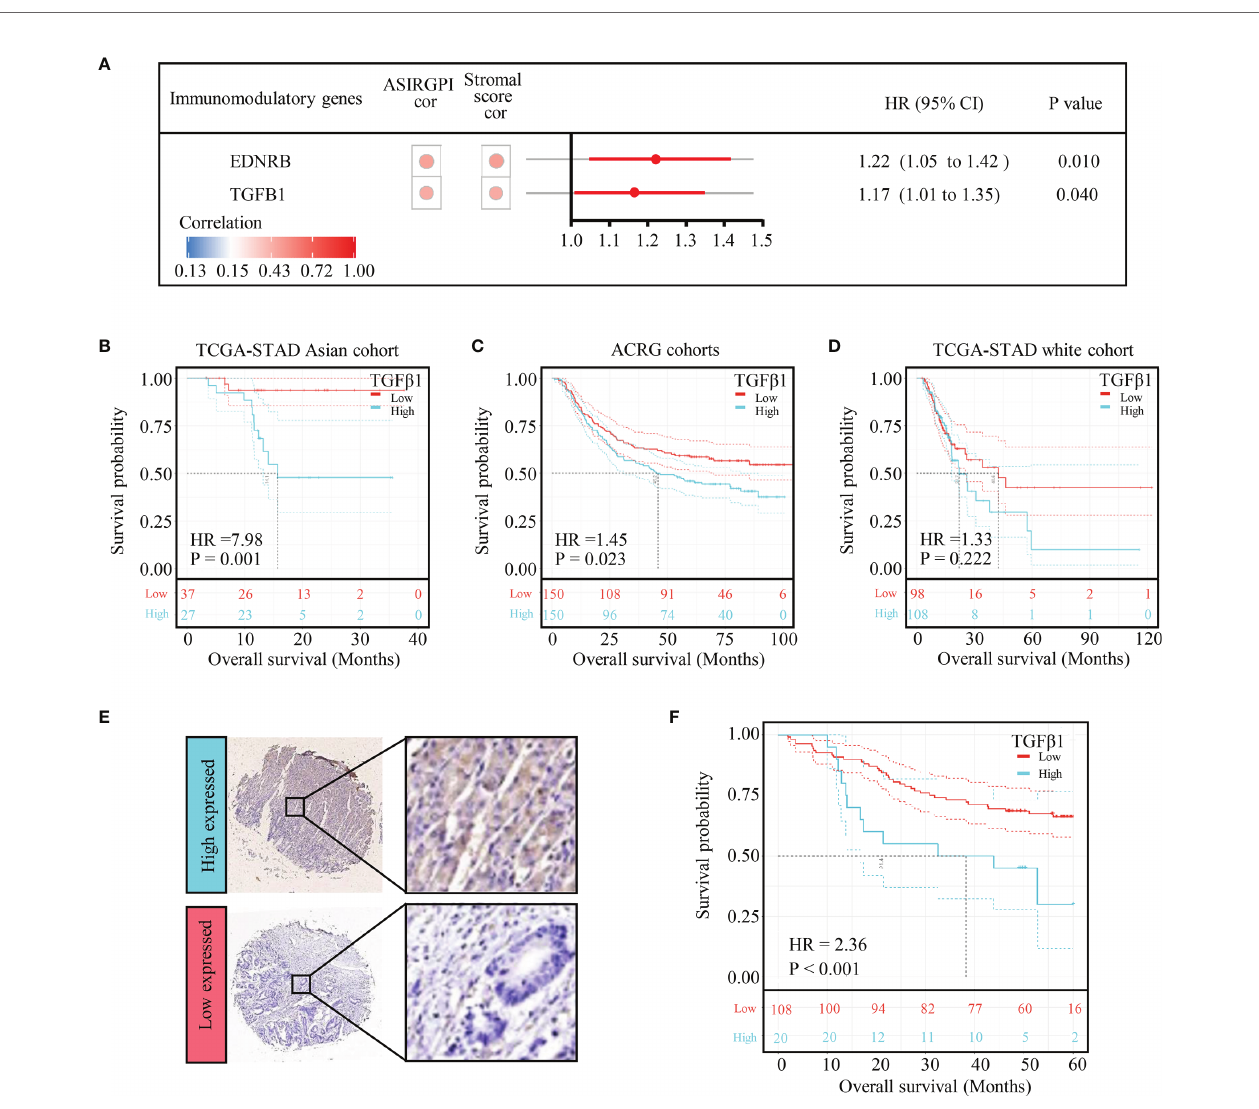
FIGURE 7 | TGFB1 was validated to be the therapeutic target in AGC patients. (A) Among the 29 immunomodulatory genes detected in both TCGA and ACRG databases, only EDNRB and TGFB1 were related to risk score (Pearson ’ s correlation test, |r| ≥ 0.40, p < 0.05) as well as overall survival (log-rank test p-value < 0.05). The circular data markers indicate estimated hazard ratios. The error bars represent the 95% CIs. (B) Kaplan – Meier curves for the high- (n = 27) and low- (n = 37) risk score patient groups in the TCGA-STAD Asian cohort. Log-rank test, p = 0.001. (C) Kaplan – Meier curves for the high- (n = 150) and low- (n = 150) risk score patient groups in the TCGA-STAD Asian cohort. Log-rank test, p = 0.023. (D) Kaplan – Meier curves for the high (n = 108) and low (n = 98) risk score patient groups in the TCGA-STAD Asian cohort. Log-rank test, p = 0.222. (E) TGFB1 expression in gastric cancer. Local patients were dichotomized into high- and low-risk subgroups at the cutoff point (8.68) of the histochemistry score of TGFB1 expression. (F) Kaplan – Meier curves for the high- (n = 20) and low- (n = 108) risk score patient groups in the local patients. Log-rank test, p <